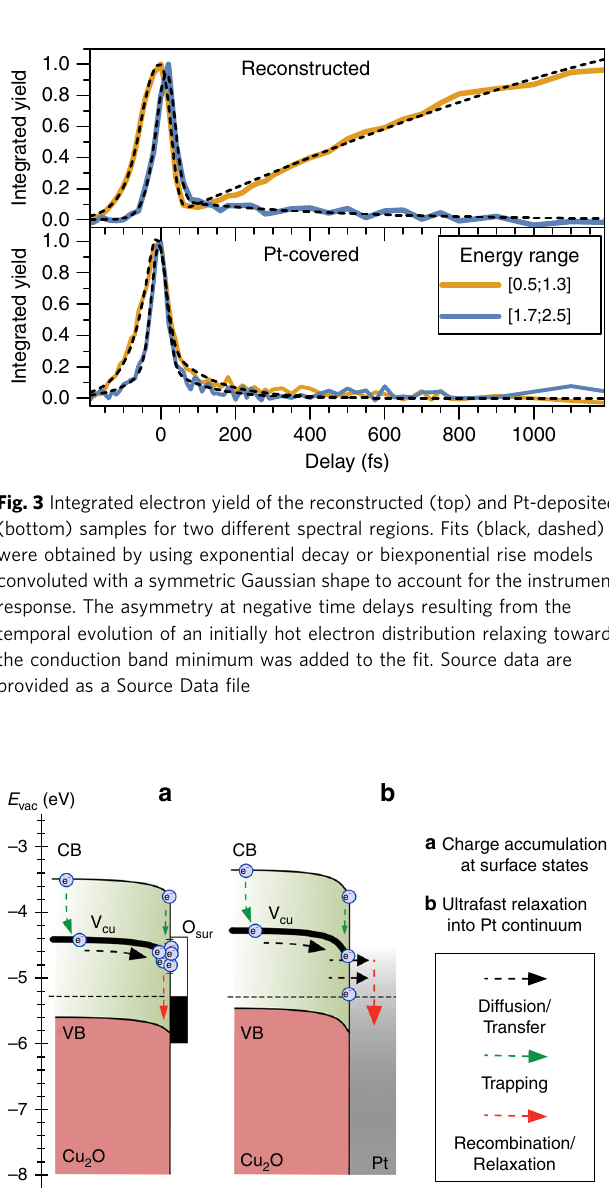
the fi rst ps after excitation (Fig. 3), consistent with ultrafast capture of conduction-band electrons or excitons into the broad mid-gap band presumably originating from Cu vacancies 36 – 38 (dotted green arrows in Fig. 4).